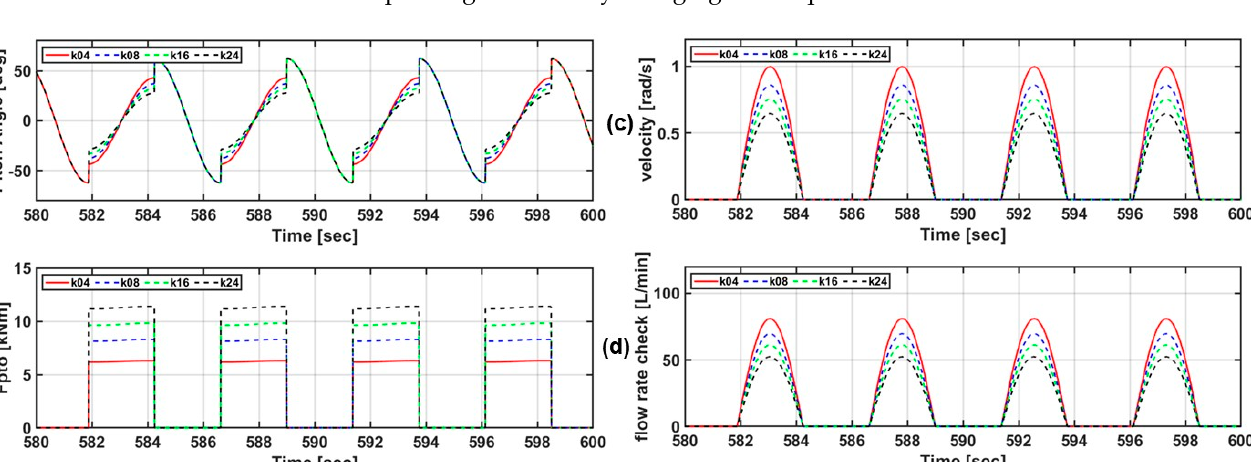
Figure 14. ( a ) Circuit pressure, ( b ) hydraulic motor rpm, ( c ) mechanical and electrical torques, and ( d ) load current according to the torque coefficient of the optimal torque control algorithm under regular wave conditions (legends indicate torque coefficients). In conclusion, the maximum power generation can be obtained by adjusting the torque coefficient according to the system and environmental characteristics of the opti- mal torque control algorithm. Figure 15 shows the input, mechanical, and electrical power generation according to the torque coefficient of the optimal torque control algorithm under regular wave condi- tions. The overall efficiency of the PTO system is quite high, so absorbing as much energy